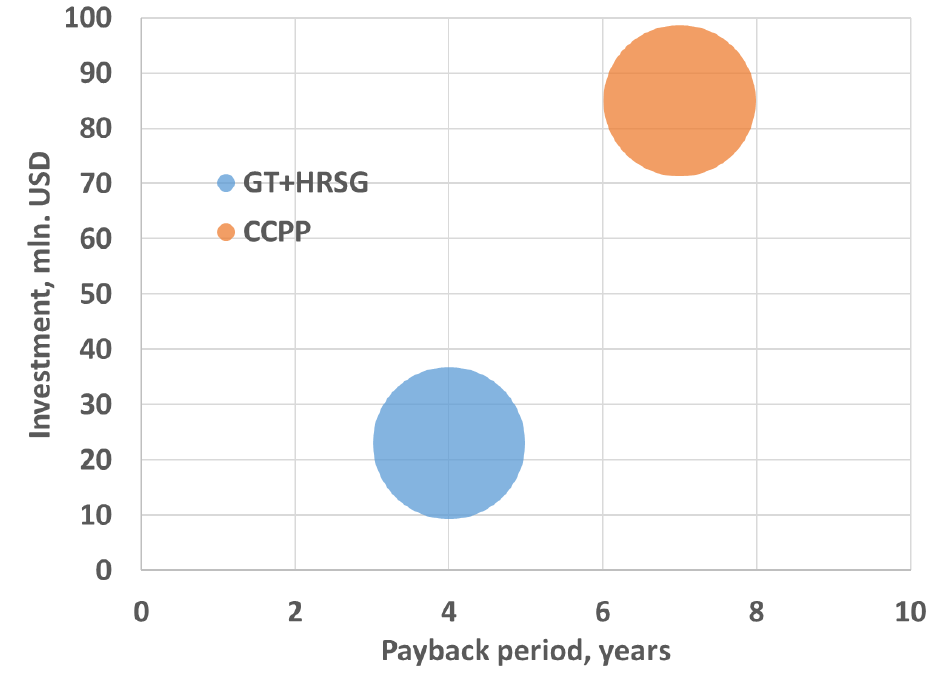
Figure 15. NPV indicators as a percentage of IRR.